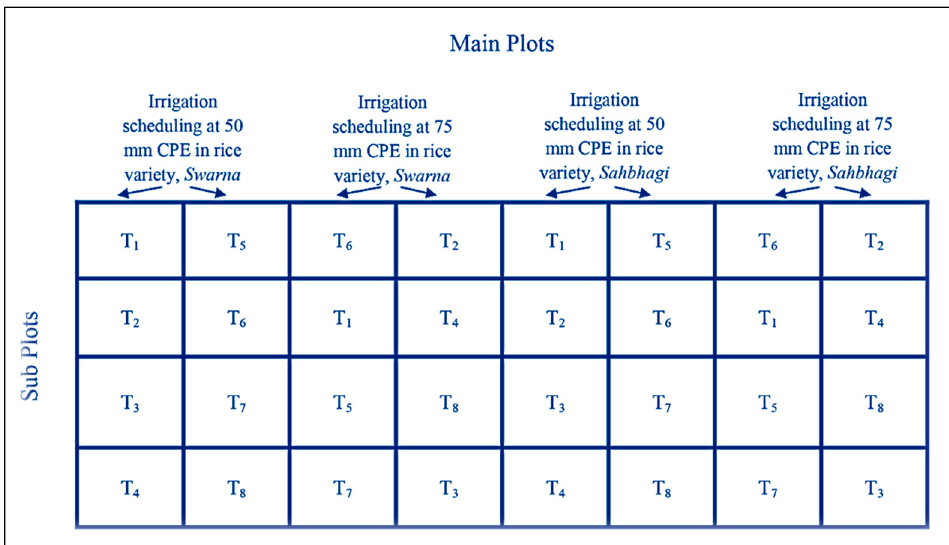
Figure 1. Field arrangement of main plots and sub-plots treatments in a replication and repeated same in other two replications. CPE, cumulative pan evaporation; T 1 , 100% recommended dose of fertilizer (RDF); T 2 , 75% RDF; T 3 , 75% RDF + municipal solid waste compost (MSWC) at 10 Mg·ha − 1 ; T 4 , 75% RDF + enriched MSWC (nitrogen fixing bacteria) at 10 Mg·ha − 1 ; T 5 , 75% RDF + enriched MSWC (phosphorus solubilizing bacteria) at 10 Mg·ha − 1 ; T 6 , 75% RDF + enriched MSWC (zinc solu- bilizing bacteria) at 10 Mg·ha − 1 ; T 7 , 75% RDF + enriched MSWC ( Trichoderma ) at 10 Mg·ha − 1 , and T 8 , 75% RDF + enriched MSWC (Consortia) at 10 Mg·ha − 1 .